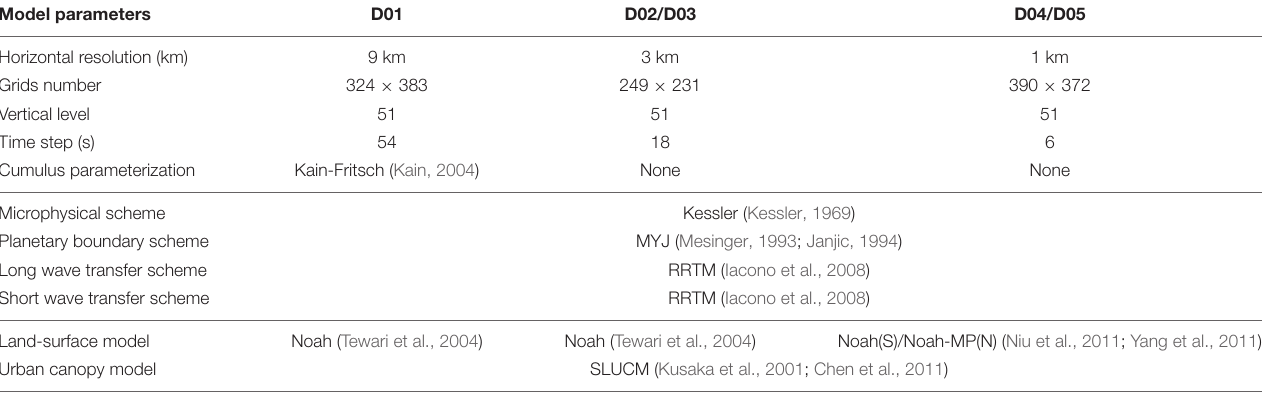
TABLE 2 | Urban canopy parameters used in this